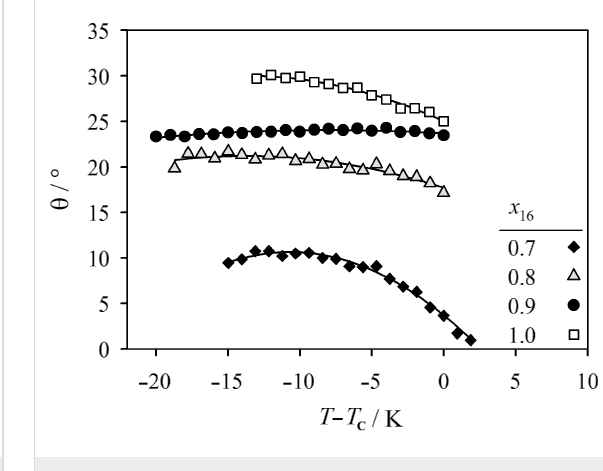
Figure 6: The tilt angle θ is plotted against the temperature difference to the phase-transition temperature T − T c for the mixtures with x 16 = 0.7 (filled diamonds), 0.8 (grey triangles), 0.9 (filled circles) and the pure compound PhP16 (open squares).